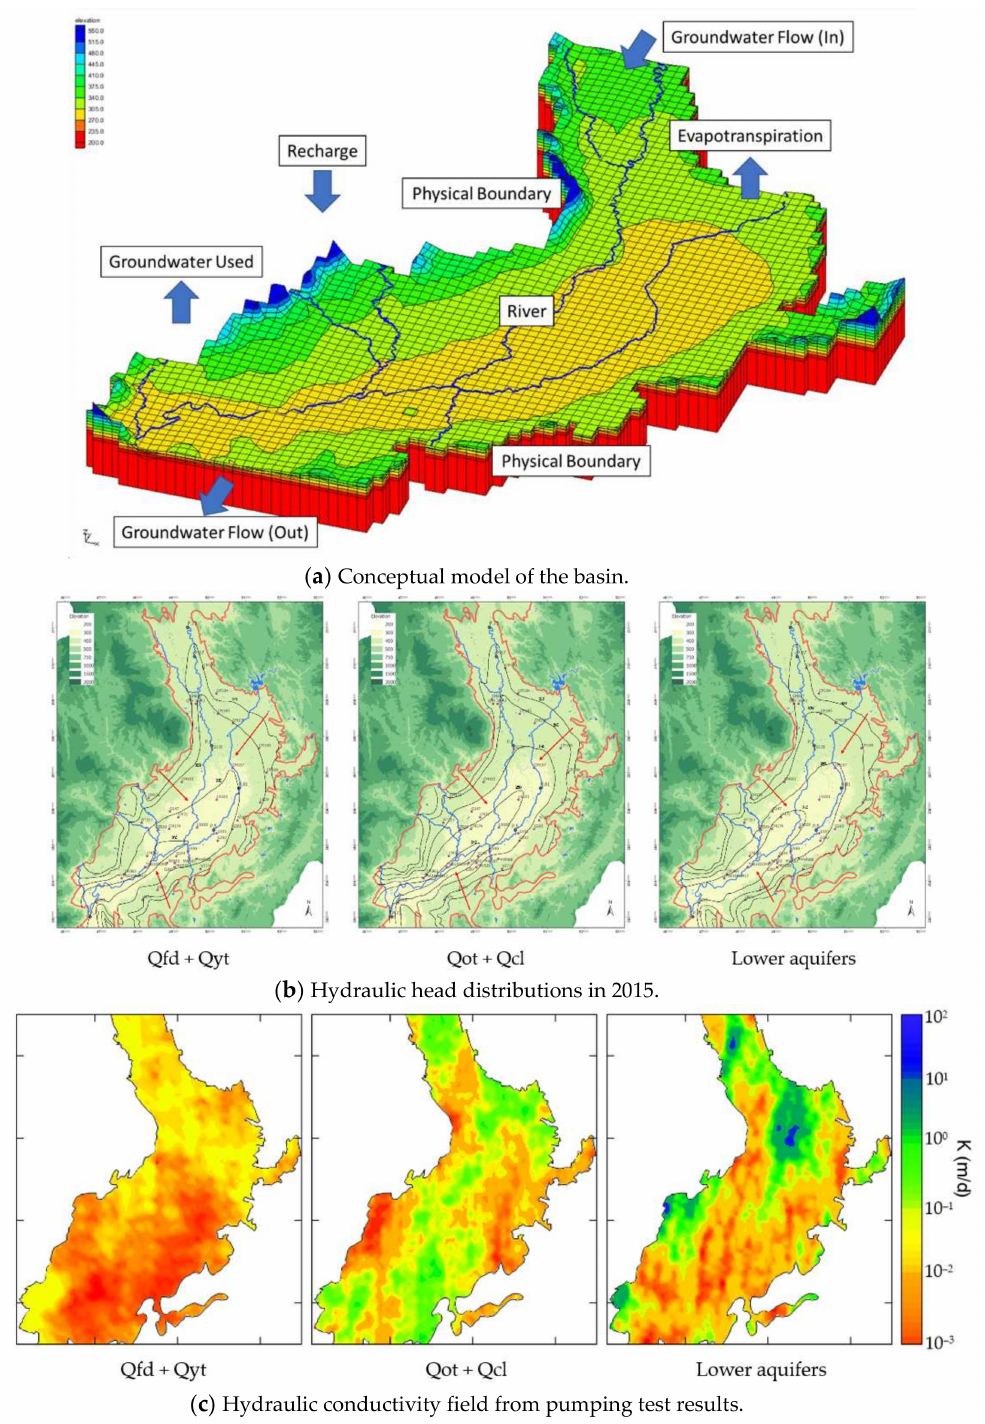
Figure 4. The conceptual model of the Chiang Mai basin and general groundwater flow directions in Qfd, Qyt + Qot, and lower aquifers ( a ) and hydraulic head distribution and general groundwater flow directions in aquifer units in the year 2015 ( b ) and hydraulic conductivity field interpolated from pumping test results and ( c ) Hydraulic conductivity field from pumping test